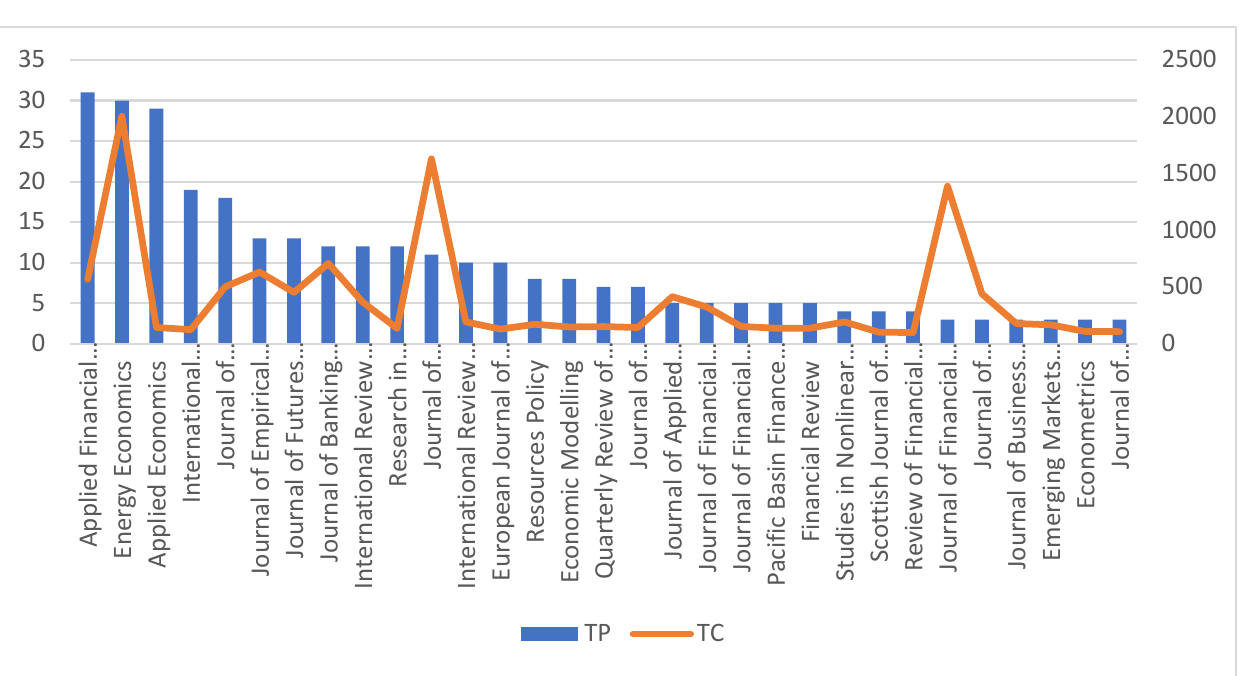
Table 3. Ranking of top 20 influential Journals.